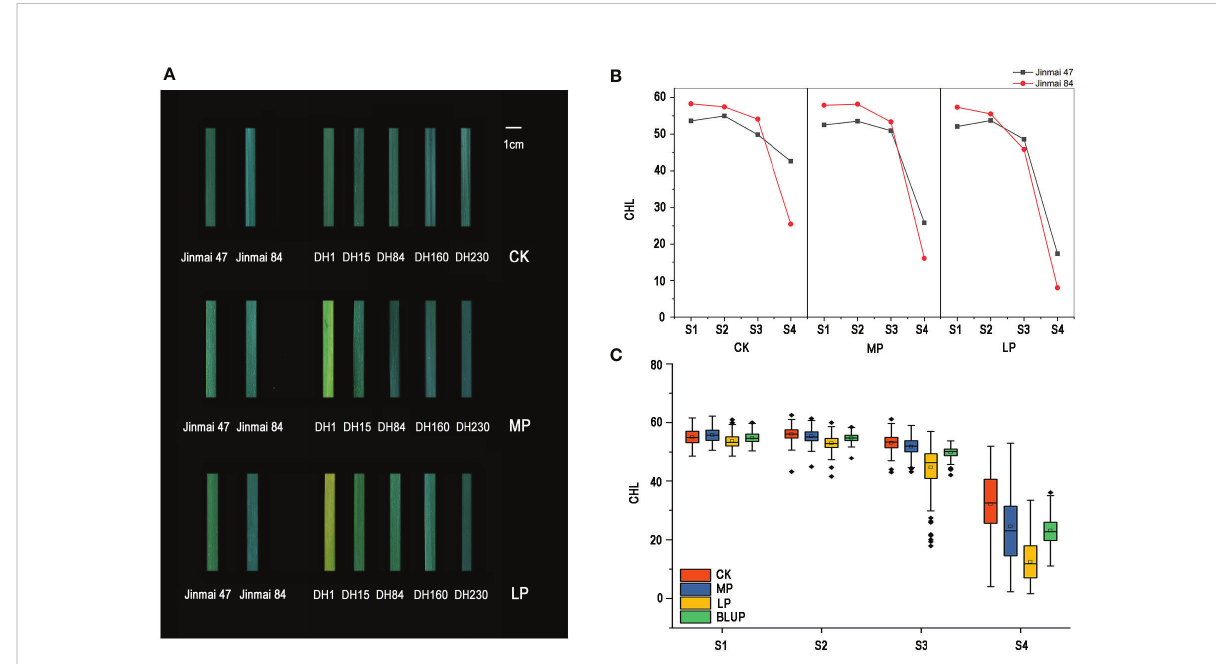
FIGURE 1 Leaf phenotype of parents and lines of DH1 population (A) . Each leaf intercepts an equal area. Changes in chlorophyll content of parents (Jinmai 47 and Jinmai 84) under normal (CK), medium (MP), and low phosphorus (LP) conditions at four stages (B) . Box diagram of chlorophyll content change in DH1 populations under three phosphorus conditions at four stages after fl owering (C)